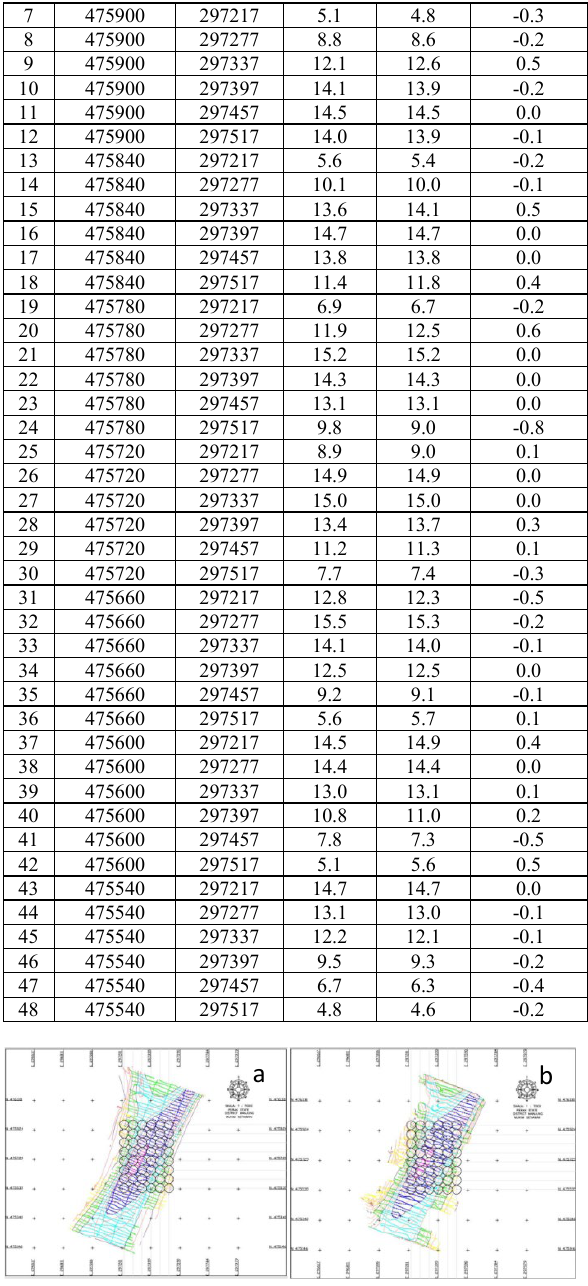
Figure 21. The bathymetric plan plotted using AutoCAD. a) The bathymetric plan in 2017 and b) the bathymetric plan in 2018